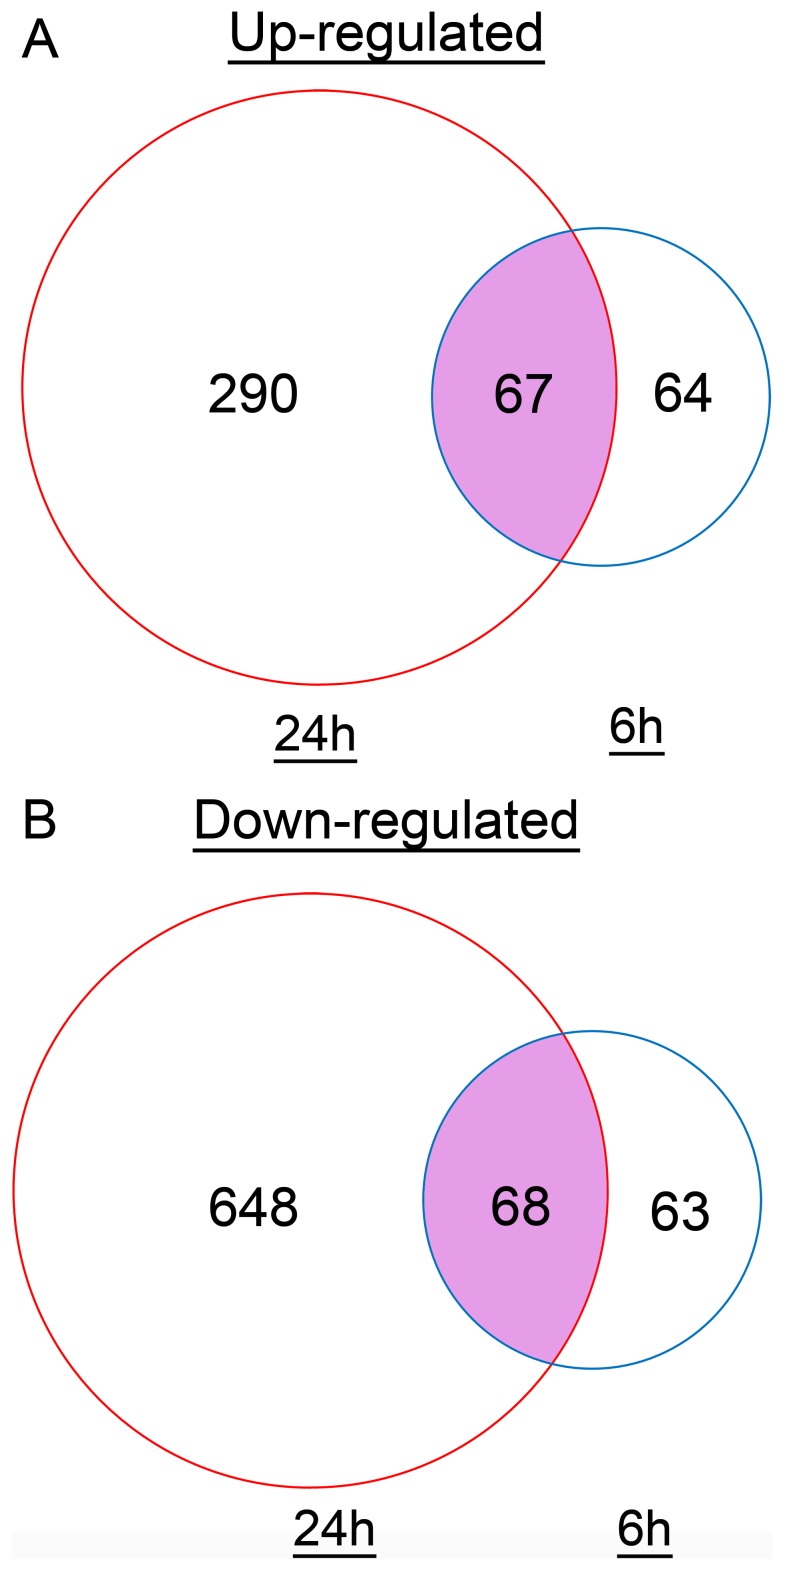
Venn diagrams of differential expressed genes at different time points after ZEA treatment.The blue circles represent 6(A) Up-regulated genes. (B) Down-regulated genes.